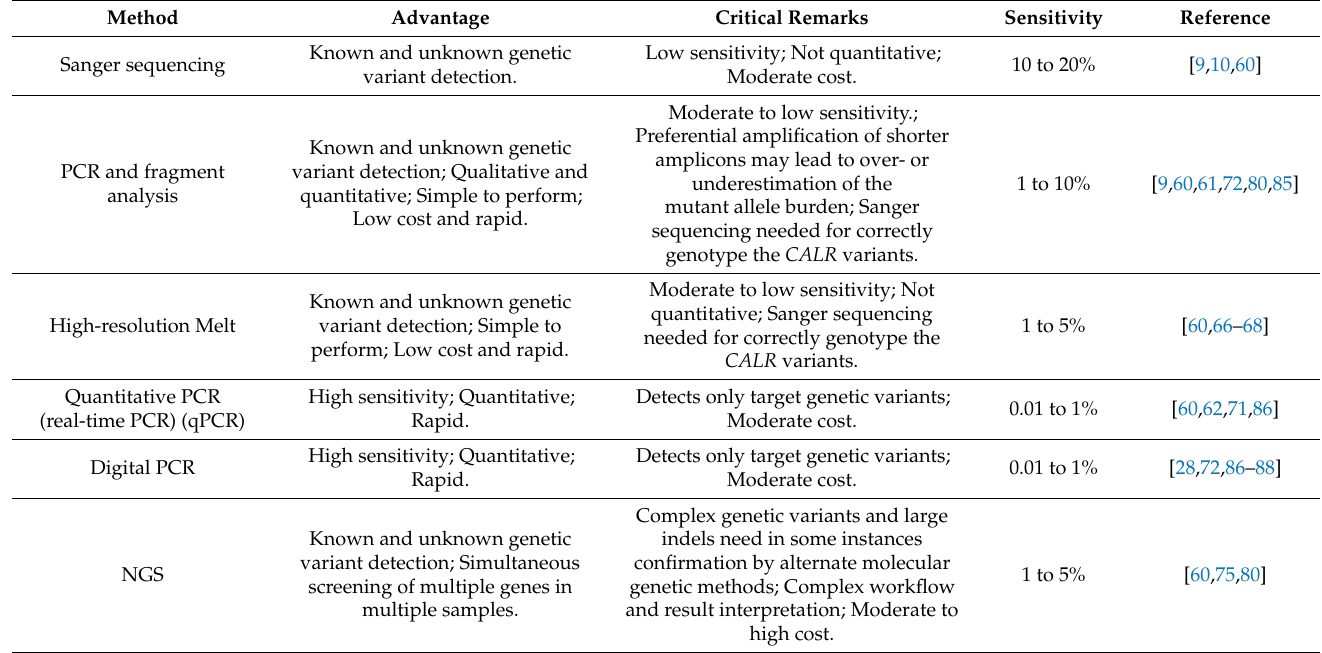
Table 1. Comparison of different molecular genetic tests for CALR mutations detection in patients with suspected myelopro- liferative